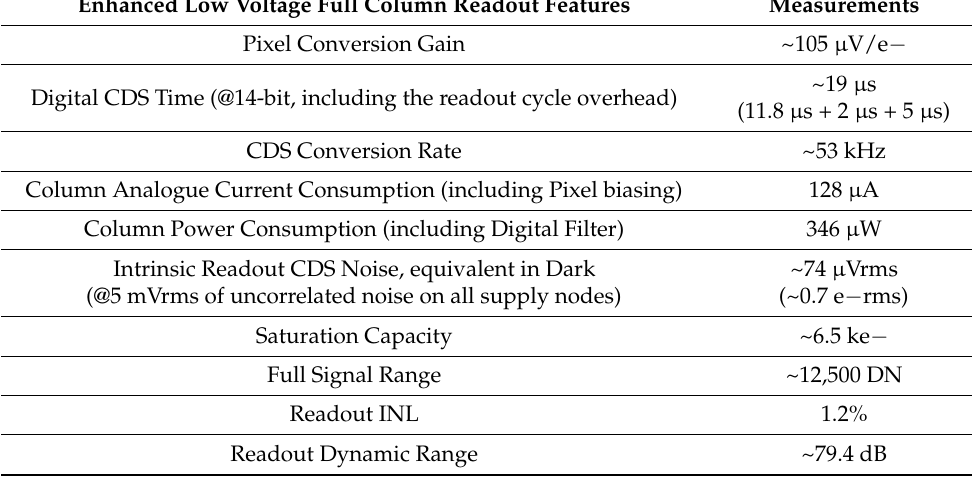
Table 2. Summary of the key Complete Readout Circuit chain (Pixel+PGA+ADC) features. Enhanced Low Voltage Full Column Readout